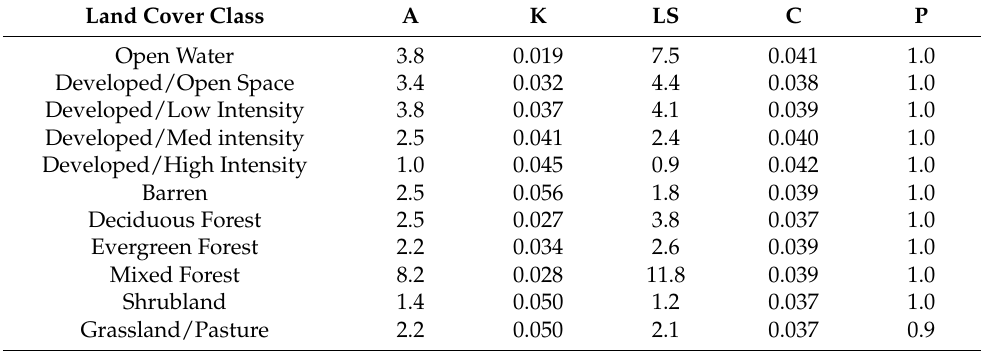
Table 9. Estimates of 8-year mean annual values of USLE parameters for each land cover class.